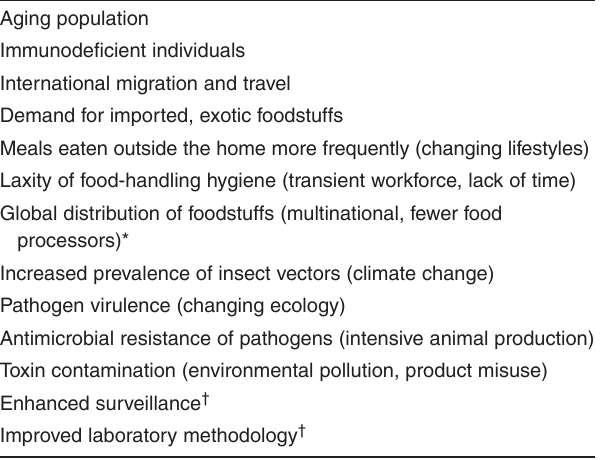
TABLE 1 Determinants that contribute to the increased occurrence of foodborne illness